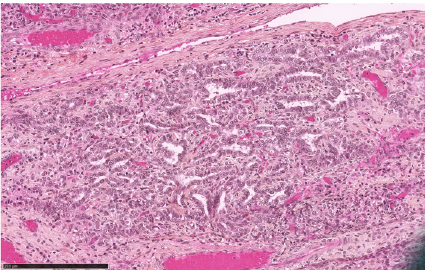
Figure 5: H&E staining at high power view. Area of retiform